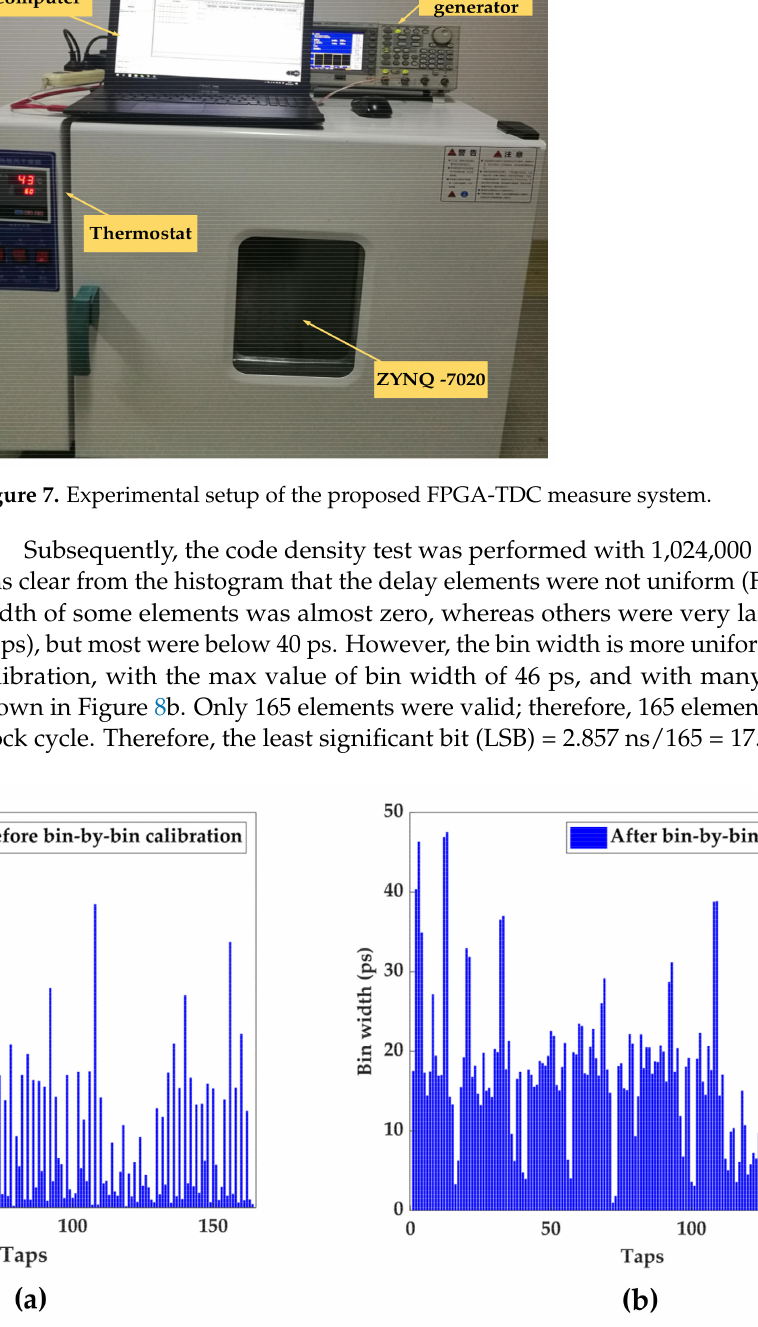
Figure 8. Measured TDC bin widths: ( a ) before bin-by-bin calibration; ( b ) after bin-by-bin